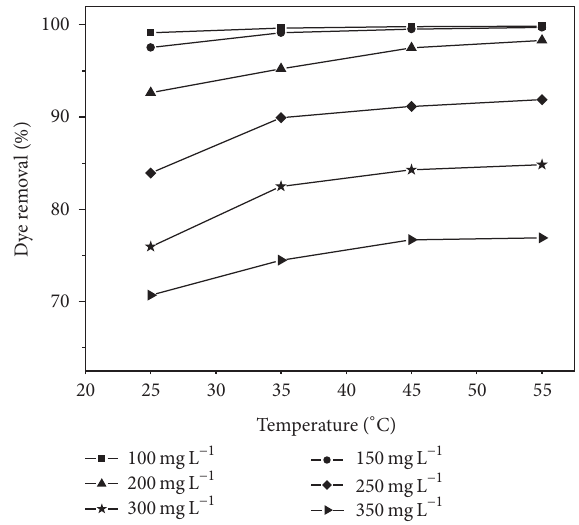
F 4: Effect of temperature on MB adsorption (concentration